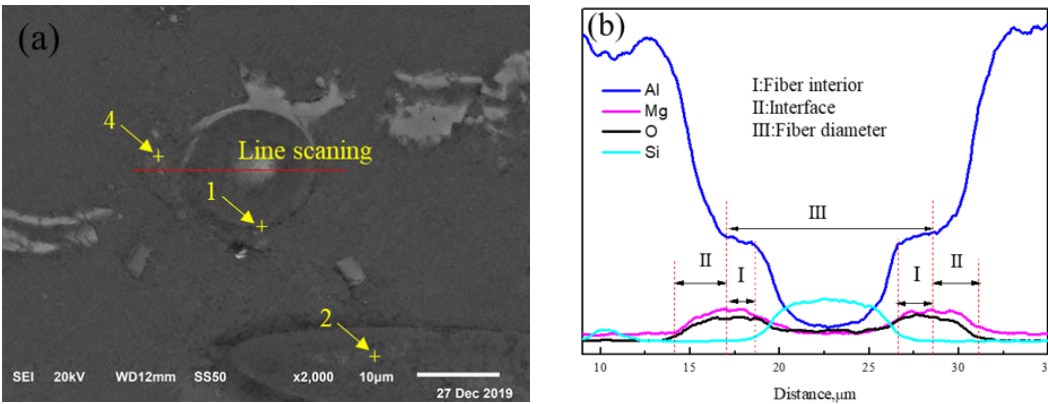
Figure 10. ( a ) Schematic diagram of line scanning area and ( b ) results of line scan Figure 10. Line scanning across BF, interfacial zone, and the matrix.